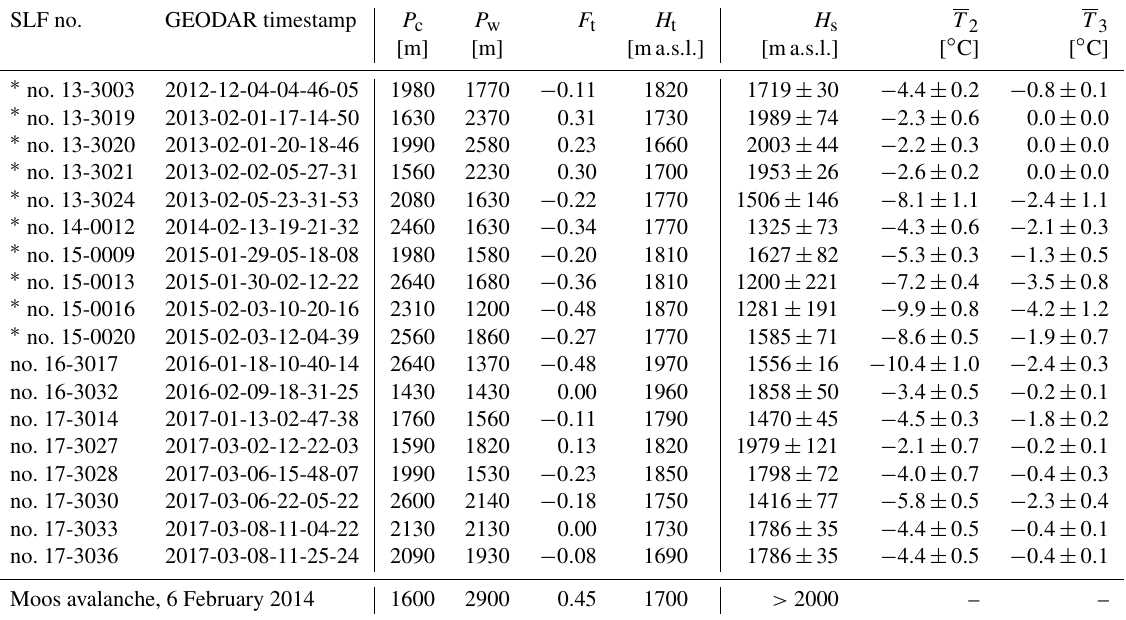
Table 1. Summary of the avalanche events with the extracted path lengths P , the transition index F t = H t , as well as the snowpack conditions H s and mean temperatures at both weather stations T 2 ; 3 . Data of avalanche events indicated with a ∗ in front of the row can be received from the GEODAR repository (McElwaine et al., 2017). SLF